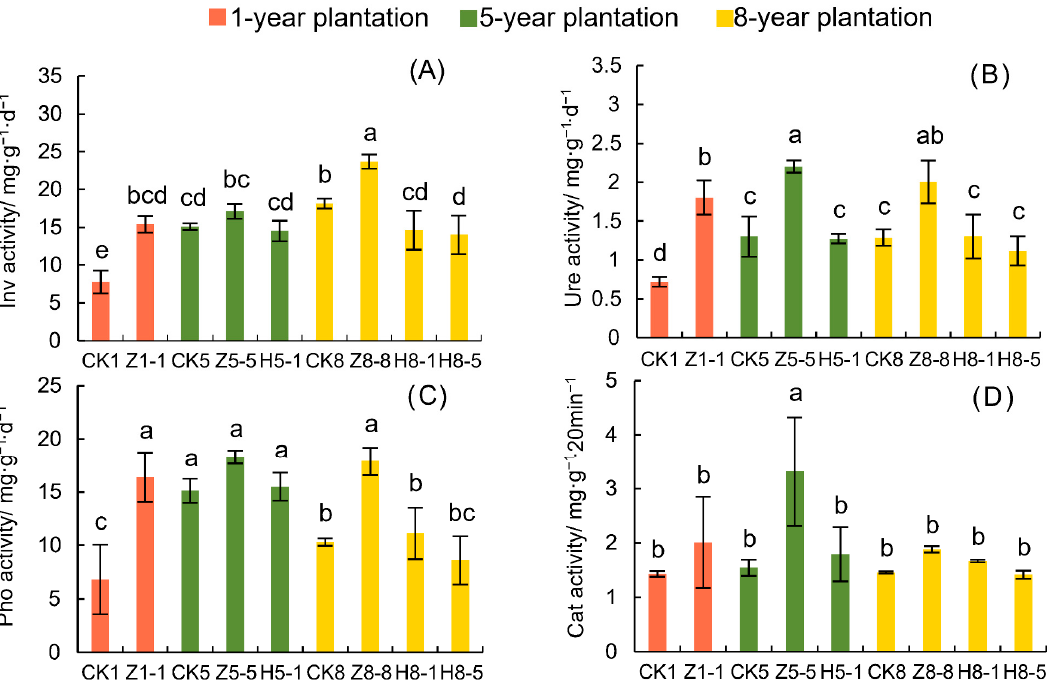
Figure 2. Soil enzyme activity under different years of growing and replanting. Note: Sample nomenclature is the same as that of Table 2. ( A ): Inv activities; ( B ): Ure activities; ( C ): Pho activities; ( D ): Cat activities. Different lowercase letters indicate a significant difference at p < 0.05.